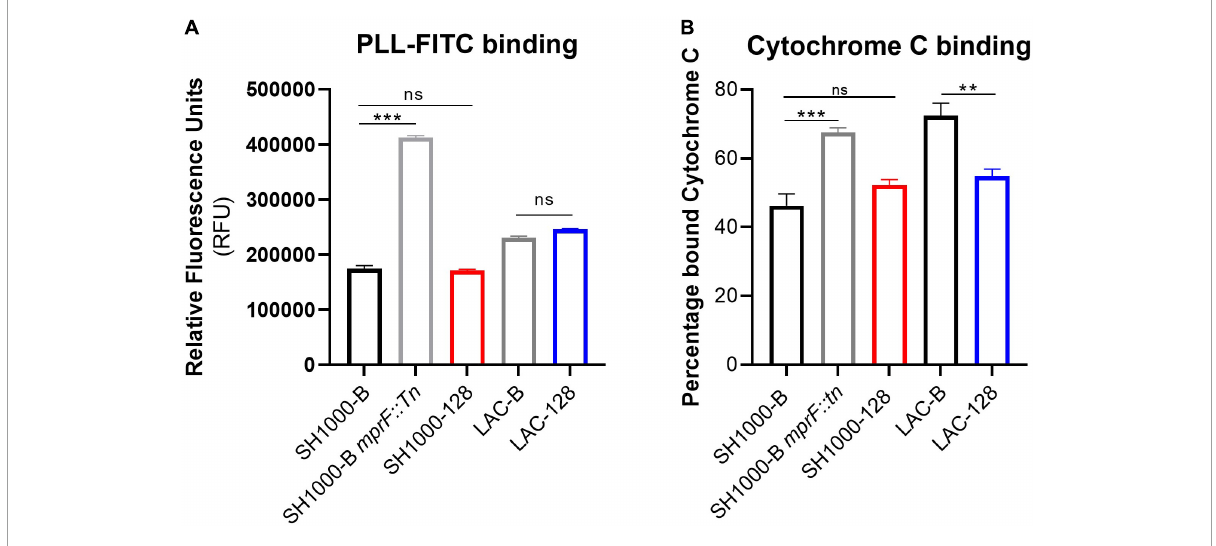
FIGURE6 S337L is associated with altered cell surface charge in strain LAC. An indication of cell surface charge was estimated through the binding ability of (A) PLL-FITC, shown by relative fluorescence units (RFU) normalized to a PBS blank and (B) cytochrome C binding depicted as percentage of bound cytochrome C normalized to a MOPS blank. The bars represent the mean of three biological replicates and the error bars the standard deviation. A one-way ANOVA was performed on SH1000-B, SH1000-B mprF::Tn , and SH1000-128, whereas a paired Student’s t -test was performed between LAC-B and LAC-128. “ns” denotes not significant, significance was determined as the following p values: **0.01;